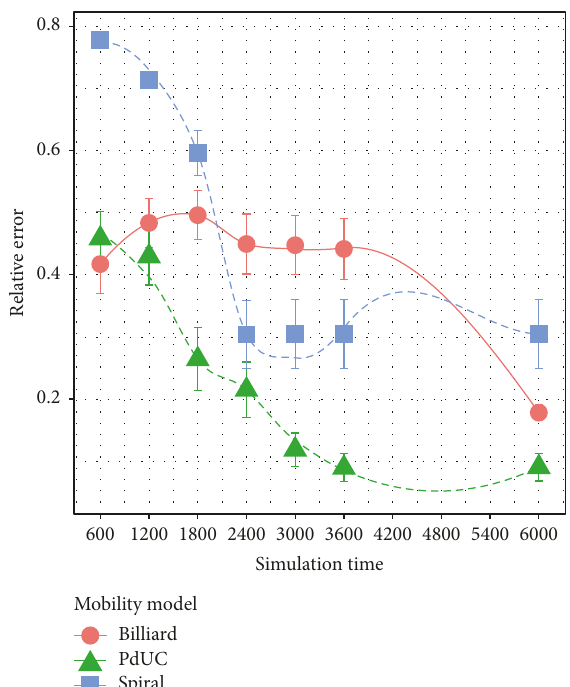
Figure 14: Relative error comparison between PdUC, Billiard, and Spiral mobility models at different times when only considering values higher than 150